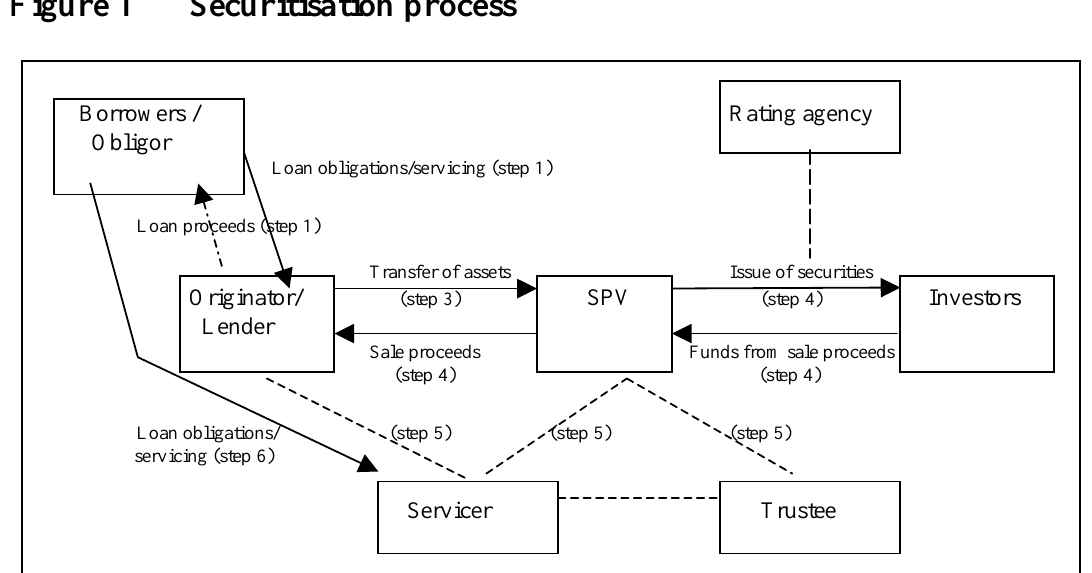
Figure 1 Securitisation